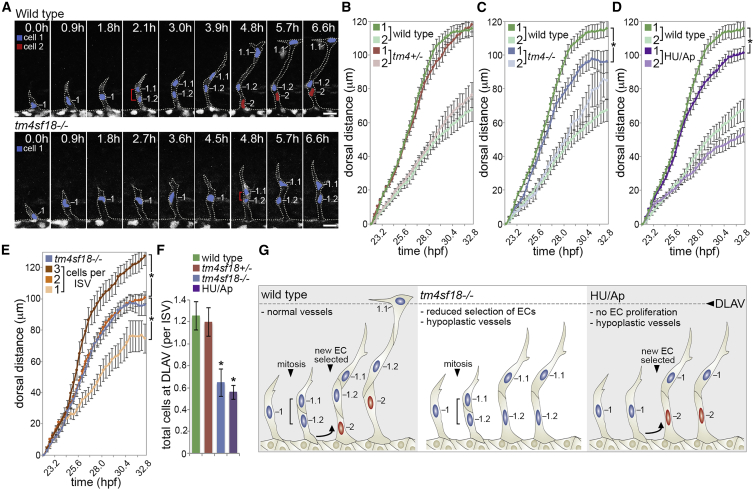
Hypocellular Vessels in tm4sf18−/− Mutants Fail to Extend Appropriately(A) Time-lapse images of sprouting ISVs in WT and tm4sf18−/−Tg(kdrl:nlsEGFP)zf109 embryos from 19 hpf. Brackets indicate dividing cells. Nuclei are pseudocolored. ISVs appear shorter in the absence of tm4sf18.(B–D) Quantification of the dorsal movement of tip (cell 1) or stalk (cell 2) ECs in WT and tm4sf18+/− (B), tm4sf18−/− (C), or HU/Ap-treated (D) embryos (n = 71 ISVs from 16 WT, 69 ISVs from 15 tm4sf18+/−, 39 ISVs from 8 tm4sf18−/−, and 89 ISVs from 22 HU/Ap-treated embryos).(E) Quantification of the dorsal movement of tip ECs in non-proliferating ISVs consisting of 1, 2, and 3 or more ECs and comparison with the motility of tip ECs in tm4sf18−/− embryos (n = 39 ISVs from 8 tm4sf18−/− embryos, as well as 17 ISVs with 3 cells, 53 ISVs with 2 cells, and 16 ISVs with 1 cell from 22 embryos).(F) Quantification of the number of ECs that reach the DLAV position in WT, tm4sf18+/−, tm4sf18−/−, and HU/Ap-treated embryos (n = 63 ISVs from 16 WT, 56 ISVs from 15 tm4sf18+/−, 31 ISVs from 8 tm4sf18−/−, and 86 ISVs from 22 HU/Ap-treated embryos).(G) Illustration of the causes of vessel hypoplasia and phenotypic effect on vessel extension.Data are means ± SEM. ∗p < 0.05, two-way ANOVA or two-tailed t test. Scale bars, 25 μm.See also Figure S4.